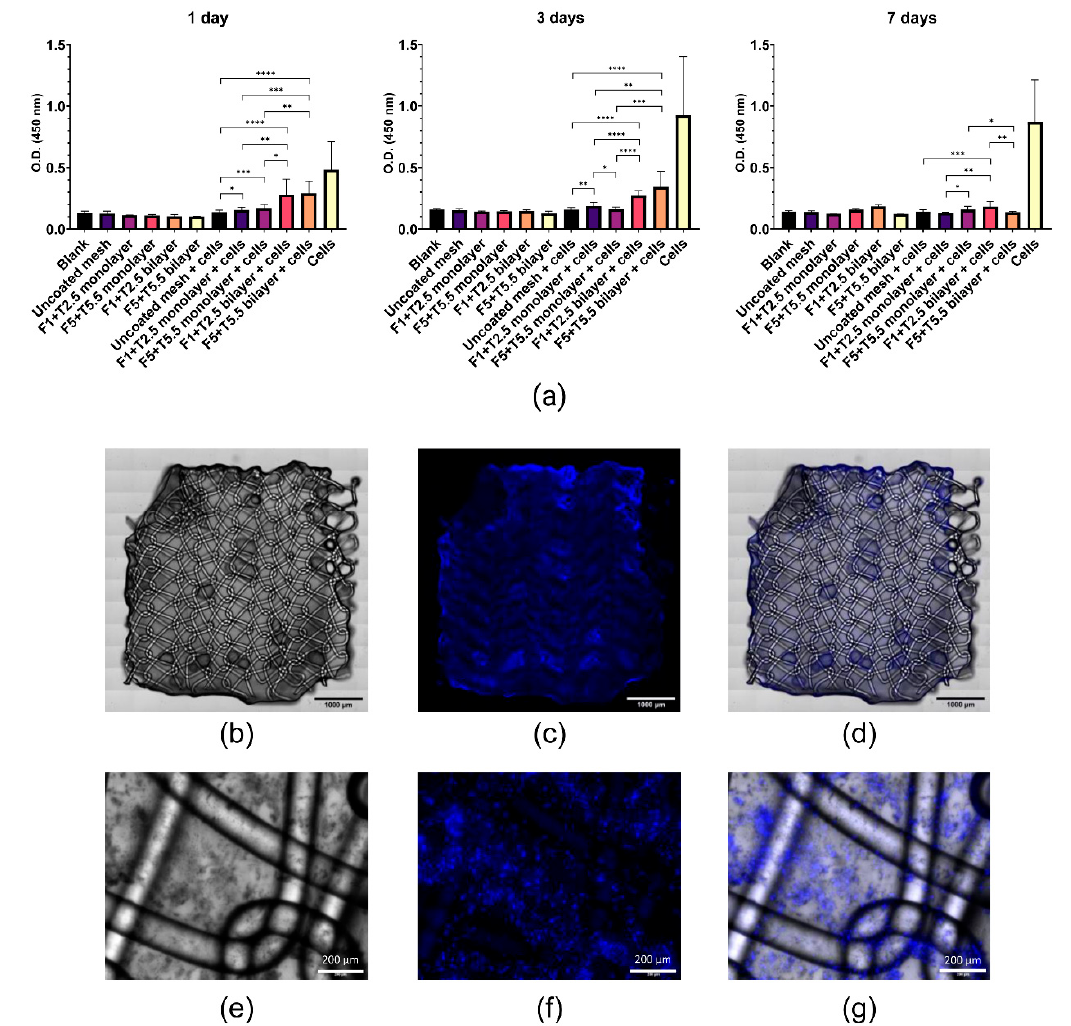
Figure 4. Viability and adhesion of menstrual blood-derived stromal cells (MenSCs) on fibrin-coated meshes. ( a ) A CCK-8 assay was performed 1, 3, and 7 days after cell seeding, measuring the absorbance at 450 nm. MenSCs seeded on uncoated meshes and MenSCs on a poly-D-Lysin-coated plate were used as negative and positive control, respectively (unpaired t -test, * p < 0.05, ** p < 0.01, *** p < 0.001, **** p < 0.0001). F 1: fibrinogen 1 mg/mL; F 5: fibrinogen 1 mg/mL; T 2.5: thrombin 2.5 IU/mL; T 5.5: thrombin 5.5 IU/mL; O.D.: optical density. MenSCs, stained with Hoechst 33342, were seeded on fibrin-coated PP meshes (bilayered fibrin coating with 5 mg/mL fibrinogen and 5.5 IU/mL thrombin), previously stained with Sudan Black B. Samples were visualized under a fluorescence microscope 1 day after cell seeding. The fibrin-coated mesh was visualized under visible light ( b ) and DAPI channel ( c ), then merged ( d ). Additionally, multiple images of selected fields were acquired at different focal planes along the z-axis (10x) and the two channels, visible ( e ) and DAPI ( f ) were merged ( g ). Scale bars represent 1 mm ( b – d ) or 200 μ m ( e – g ).